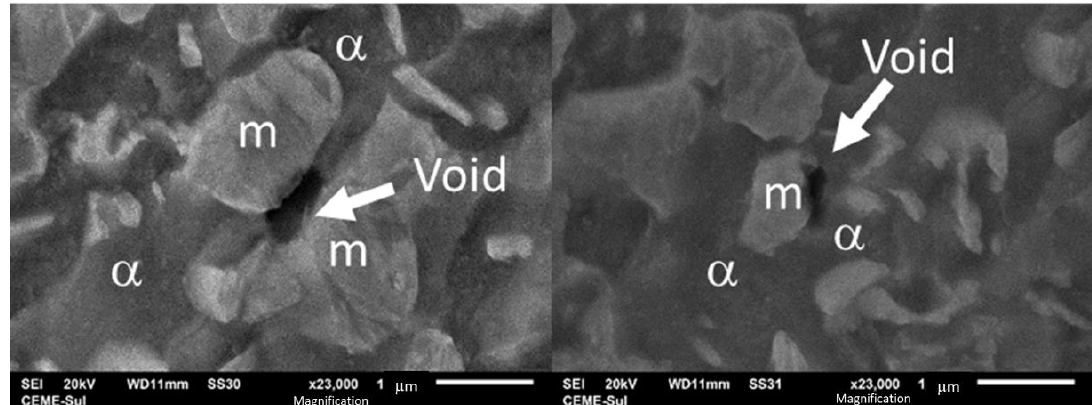
Figure 11. Void growth between the ferrite ( α ) and martensite (m) (source: author).